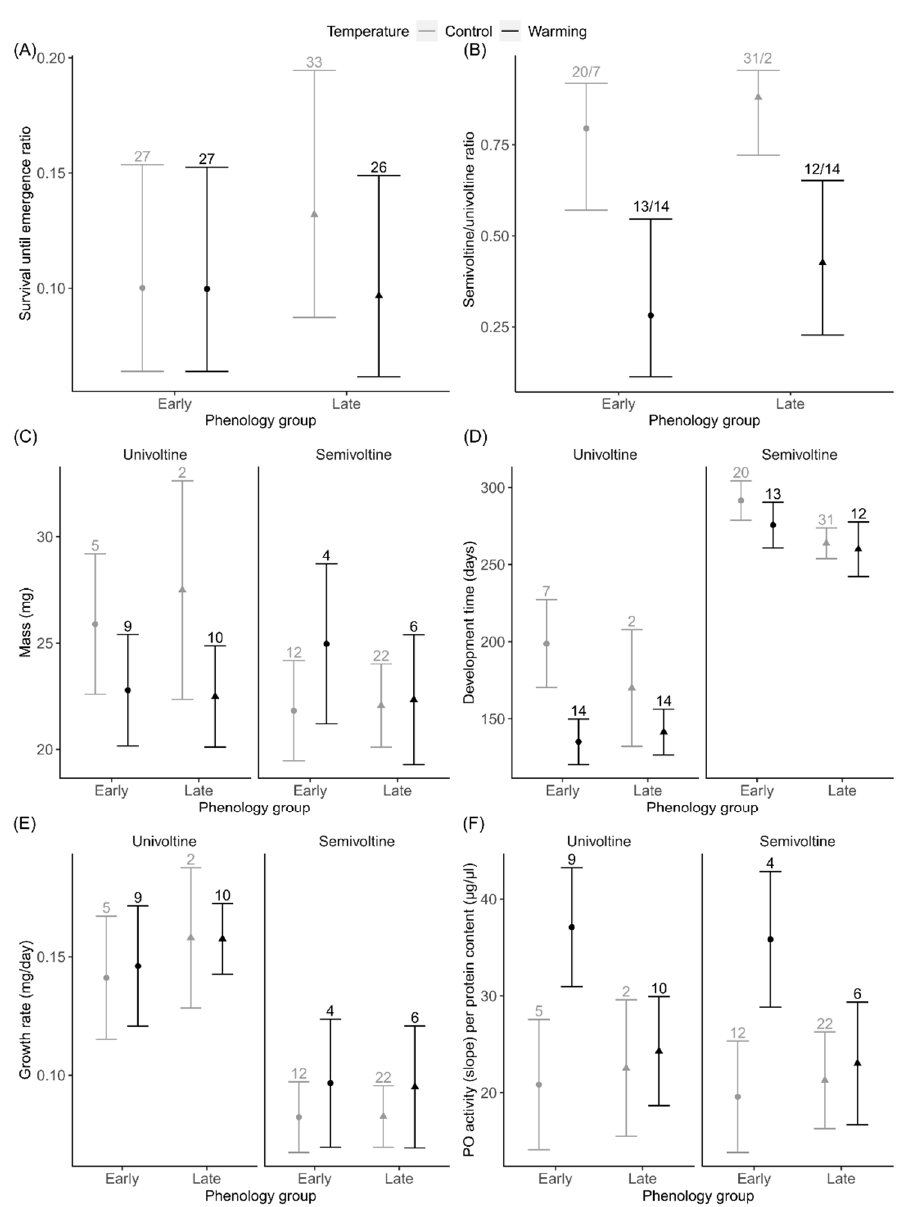
Figure 2. The effects of hatching phenology and warming on the life history and physiology of univoltine and semivoltine Ischnura elegans : ( A ) larval survival until emergence (ratio of surviving to all); ( B ) voltinism (ratio of semivoltine to univoltine); ( C ) mass at emergence; ( D ) development time; ( E ) growth rate; ( F ) phenoloxidase (PO) activity. Note that the voltinism effect was excluded from the survival analysis because survival was estimated at emergence only, and not between growth seasons. Error bars indicate estimated 95% CI. The numbers at the top of the error bars represent the number of damselflies within each group.